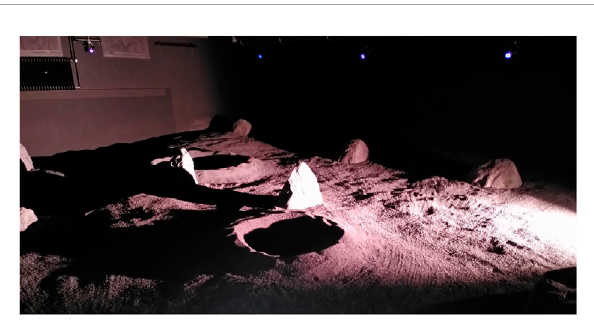
FIGURE 3 LunaLab, University of Luxembourg. This facility is equipped with an illumination system that resembles the lighting conditions of the lunar south